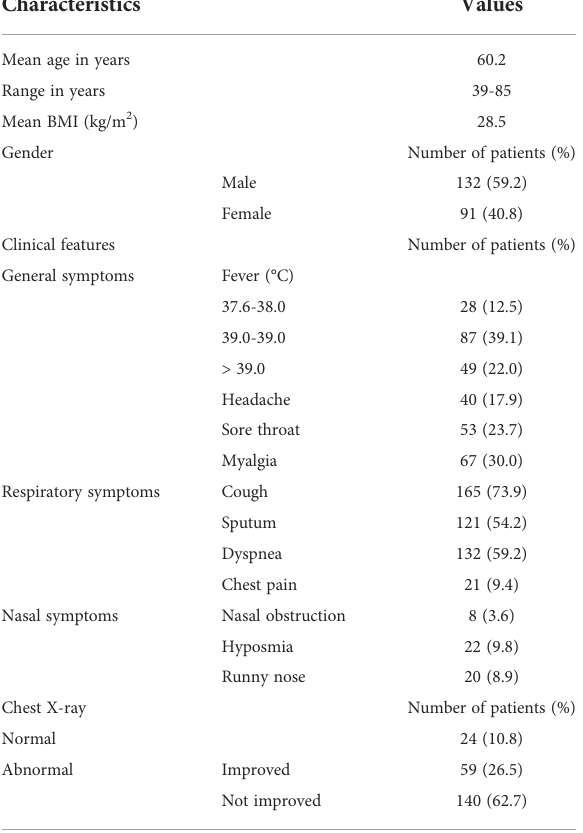
TABLE 1 Clinical characteristics of COVID-19 patients (N = 223).